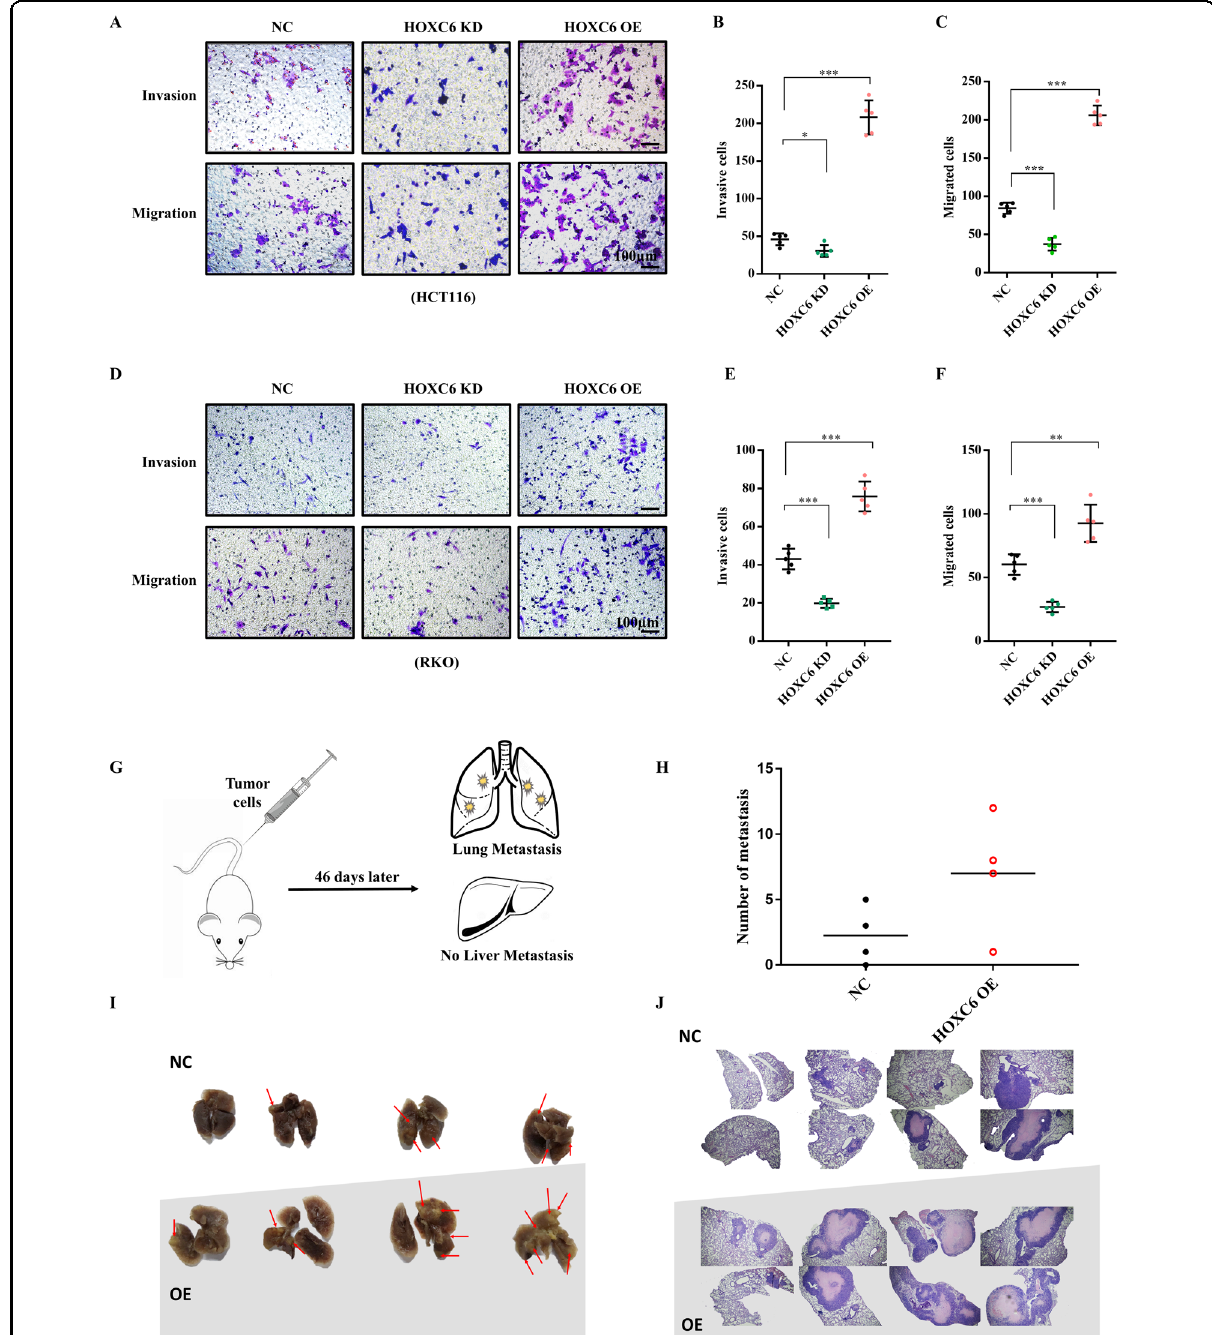
Fig. 3 Overexpression of HOXC6 promotes the migration and invasion of CRC cells in vitro and in vivo. A Transwell experiments with and without matrigel with HCT116 cells in the NC HOXC6-KD and HOXC6-OE groups. Scale bars indicate 100 µm. B Numbers of invading HCT116 cells in the NC, HOXC6-KD, and HOXC6-OE groups. C Numbers of migrating HCT116 cells in NC, HOXC6-KD, and HOXC6-OE groups. D Transwell experiments with and without matrigel of RKO cells in the NC HOXC6-KD and HOXC6-OE groups. E Numbers of invading RKO cells in the NC HOXC6-KD and HOXC6-OE groups. F Numbers of migration RKO cells in the NC HOXC6-KD and HOXC6-OE groups. G Schematic diagram of a metastatic tumor model of nude mice with tumor cells injected into the tail vein. H The number of metastatic foci in mouse lungs in the NC and HOXC6-OE HCT116 groups. I Images of isolated mouse lungs in the NC and HOXC6-OE HCT116 groups. J HE staining images of mouse lungs in the NC and HOXC6-OE HCT116 groups. *: P < 0.05; **: P < 0.01; ***: P < 0.001. n.s.: no signi fi